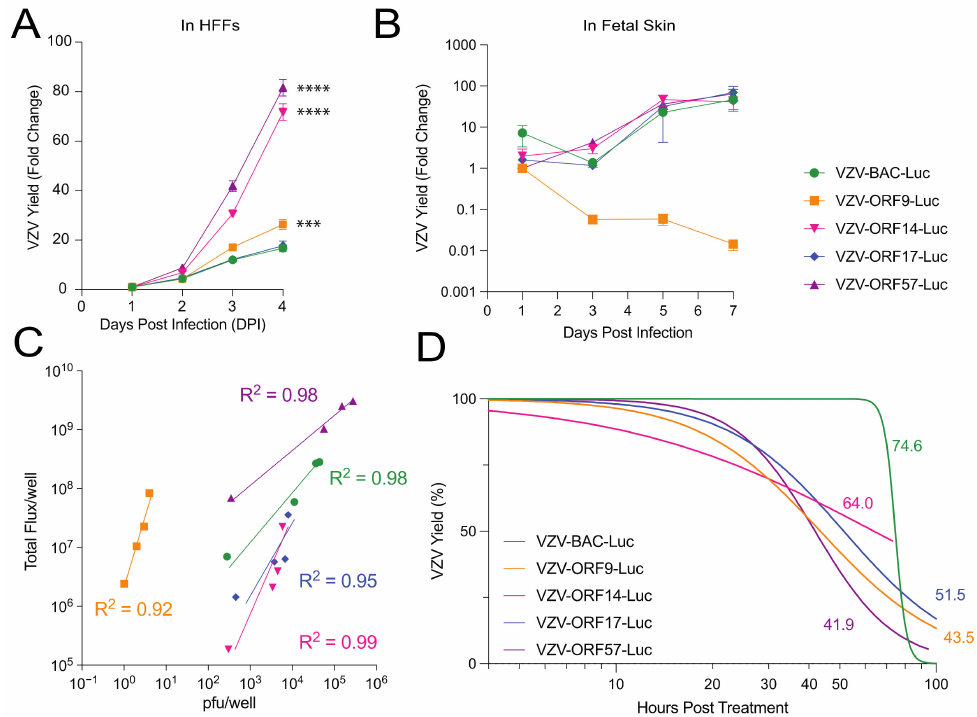
Figure 2. Evaluation of VZV-BAC-Luc and VZV-ORFx-Luc growth kinetics and bioluminescence in tissue culture and human fetal skin. Cells and skin were infected with cell-free or cell-associated virus, respectively, and grown at 37 ◦ C. Cell culture experiments ( A , C , D ) were performed in HFFs, while skin organ culture ( B ) was performed in fetal skin. ( A , B ) VZV yield was measured by bioluminescence imaging and calculated as the fold change from the average Total Flux (photons/s/cm 2 /steradian), divided by the lowest Total Flux value (DPI 1 for cells, or DPI 1-3 for SOC). ( C ) Correlation coefficients of luciferase and virus plaque number were determined for each VZV reporter virus on the basis of the relationship of pfu/well to average Total Flux per well. ( D ) HFFs and VZV were co-cultured for approximately 40 h prior to foscarnet treatment (1 mM) to block viral DNA replication. Values next to each curve represent the time (in h) for bioluminescence to decrease by 50% after treatment started and are shown in the corresponding color for each virus (individual points omitted for clarity of graph). Each point represents the mean ± SEM. Statistical analyses included one-way ANOVA with Dunnett’s post hoc test ( A , B , *** p < 0.001; **** p < 0.0001). Nonlinear regression analysis with ( C ) log–log line or ( D ) dose response—inhibition was used for best-fit lines. n = 3 biological replicates for cell-based assays; n = 6 biological replicates for skin organ